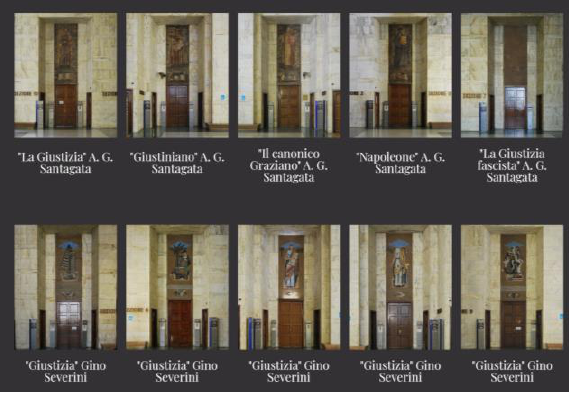
Fig. 22. Compiled image with the different mosaics. 3D models are also embedded in the open section of the website (Fig. 23). The website provides information about the creation date, author, concept, size and materials, and the location inside the building.